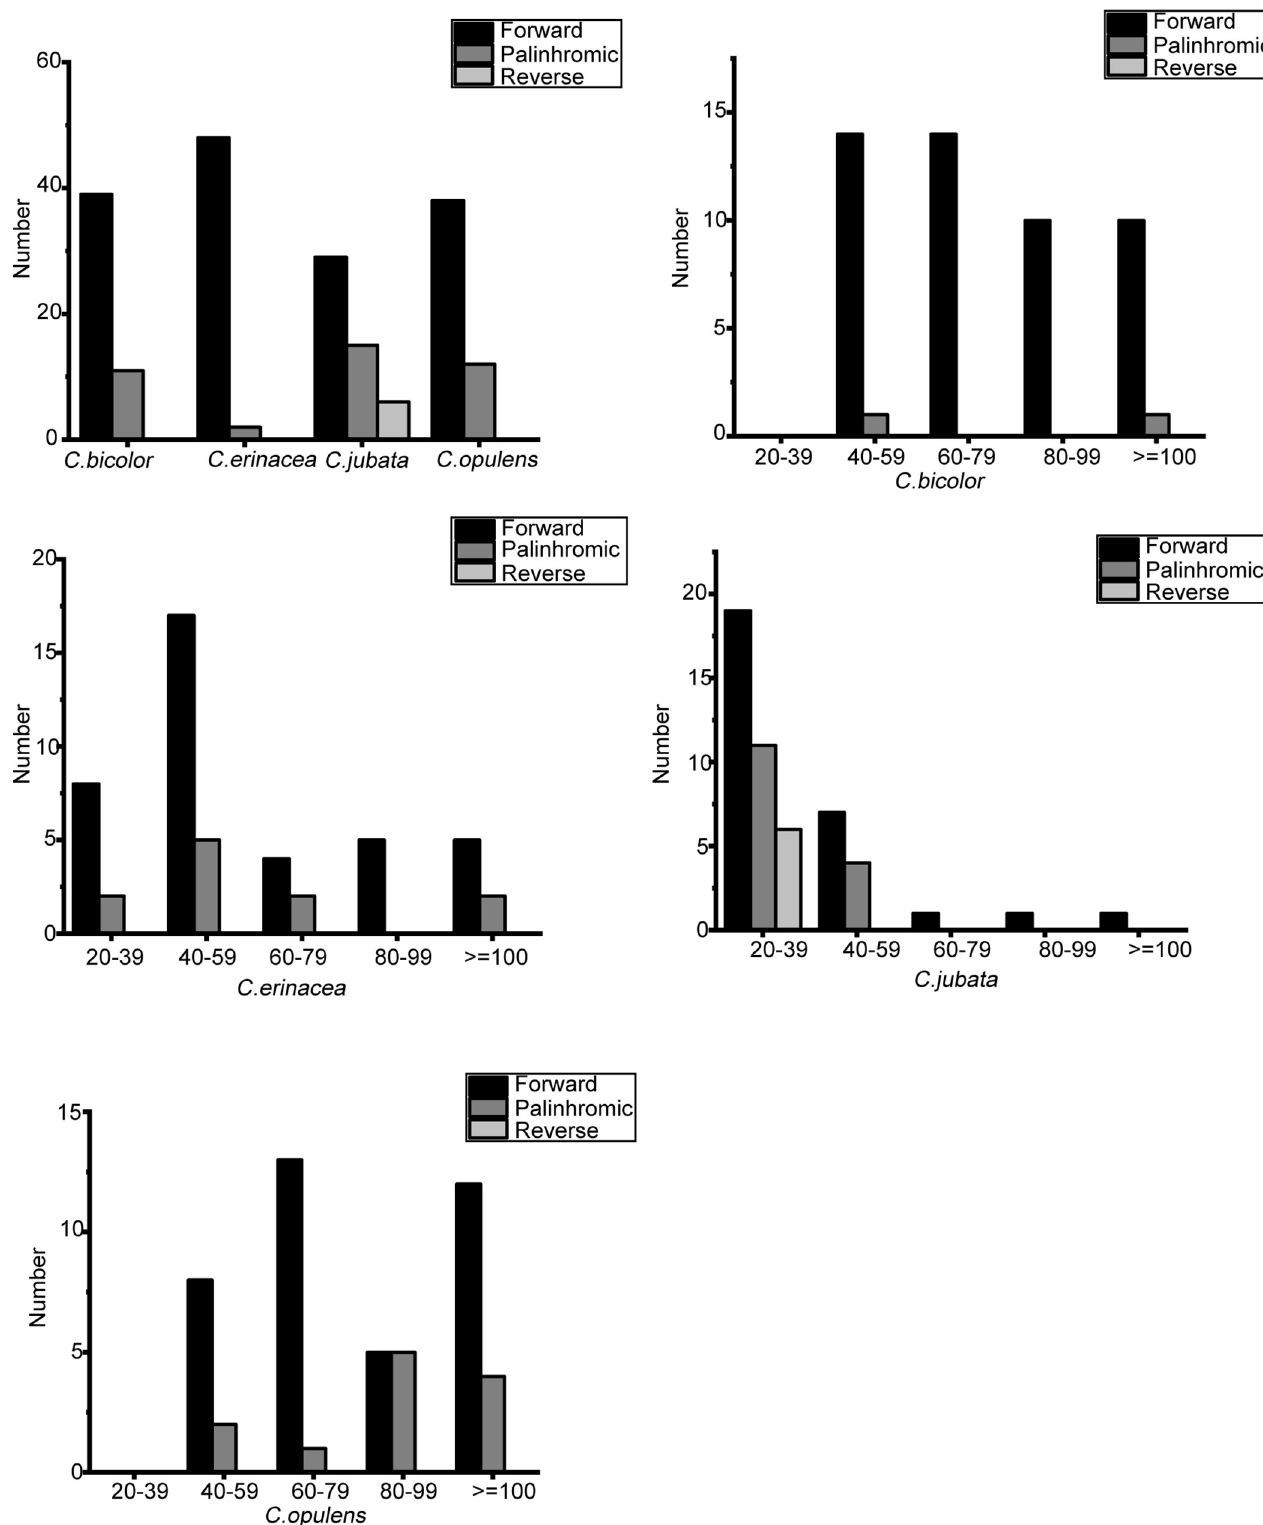
Fig 2. Long repetitive sequences in chloroplast genomes of four Caragana species.